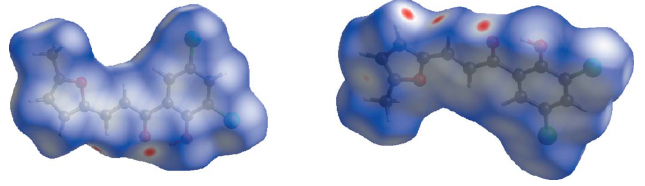
Figure 4 The Hirshfeld surface mapped over d norm in the range (cid:4) 0.1183 to +1.0844